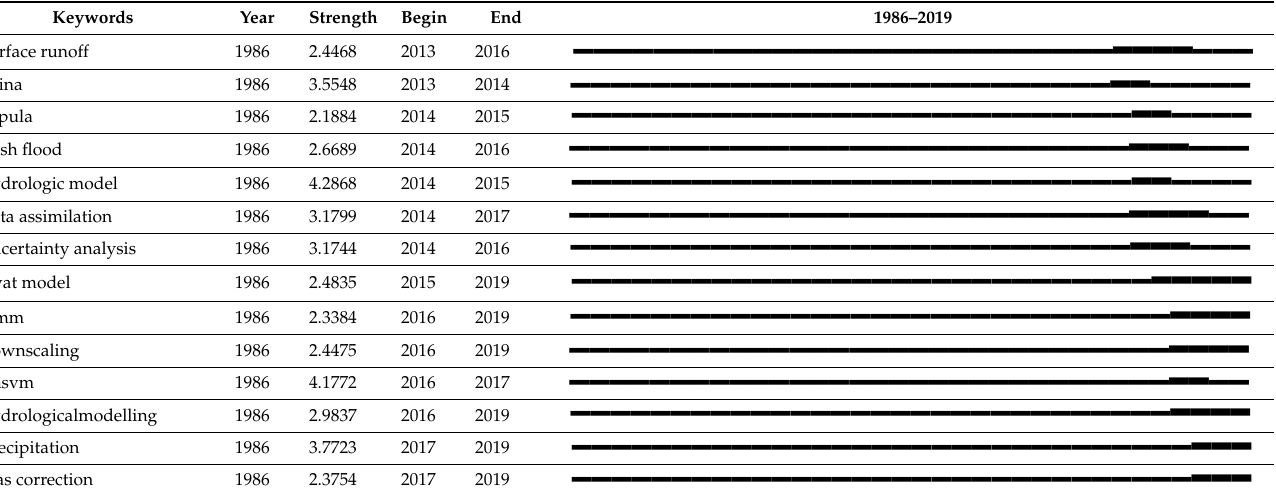
Figure 9. Keyword co-occurrence map from January to October 2020.